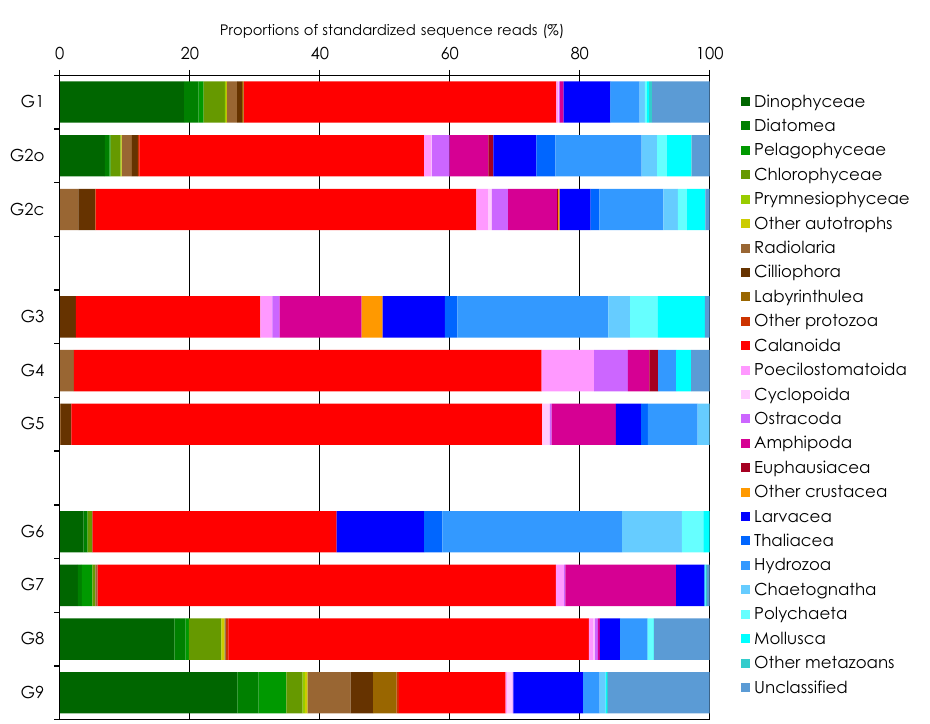
Figure 5. Average proportions of the standardized sequence reads for ten dominant prey OTUs presented for nine groups (G1 to G9) classified by Bray–Curtis similarity on a non-metric multi-dimensional scaling ordination plot. G2o: omnivorous groups for G2. G2c: carnivorous groups for